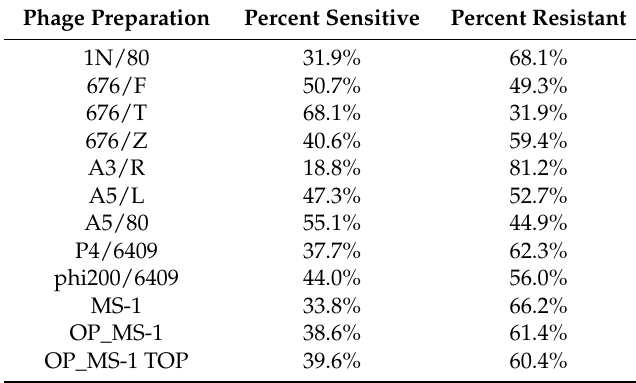
Table 1. Wet lab results of susceptibility testing. All phage preparations were tested at RTD, see